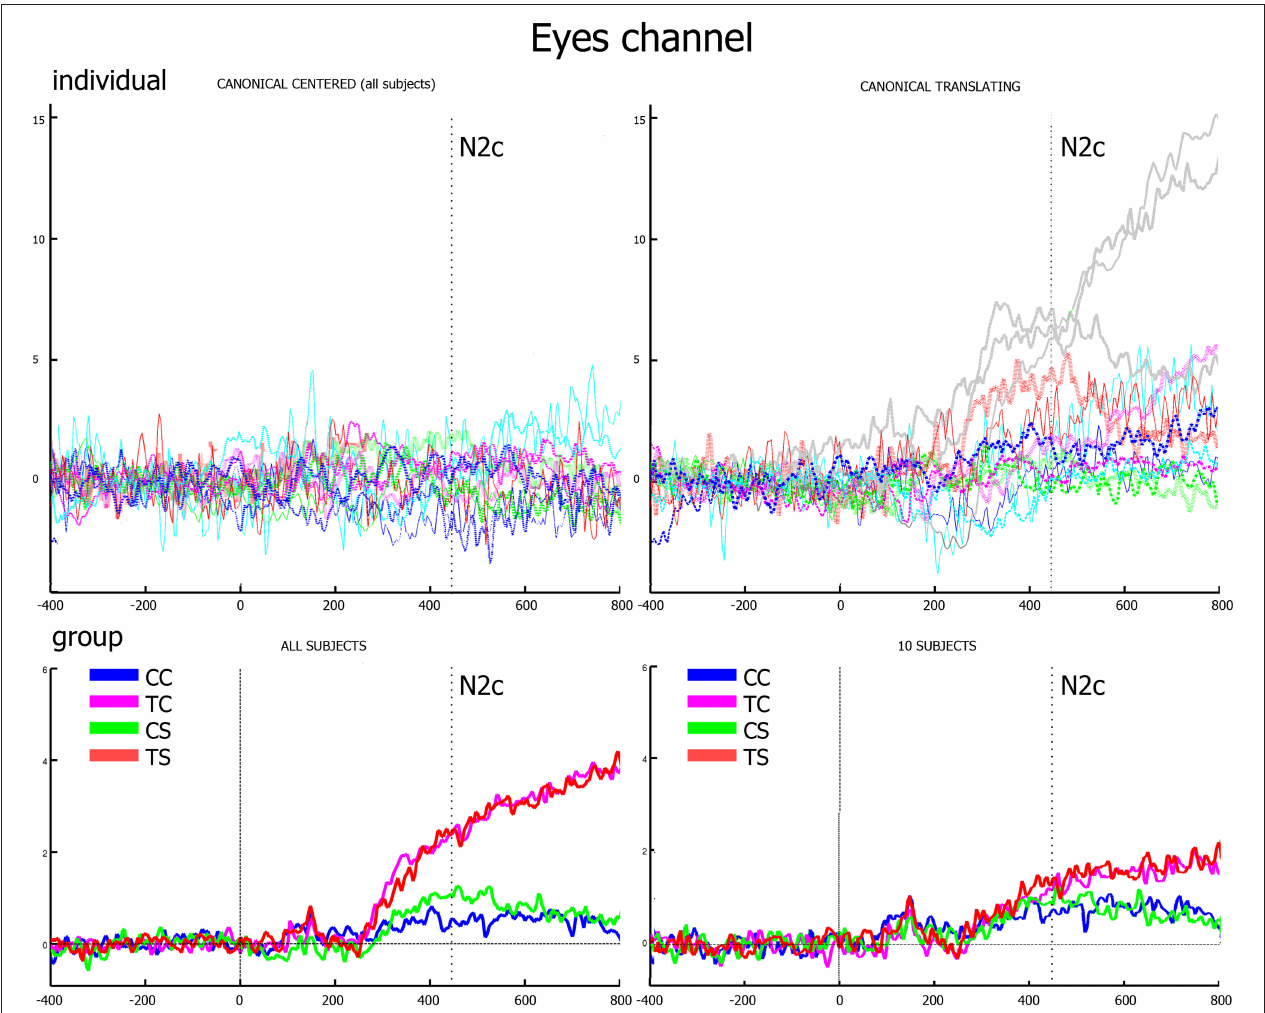
FIGURE 4 | Eye channel traces. In the upper row, the individual traces of canonical center (left) and canonical translating (right) conditions clearly show that only three subjects smoothly pursued the translating stimuli (gray lines). In the lower row, group averages of the whole group (left) and of the not-pursuing subjects group (right) are displayed. The vertical dotted line represents the N2c latency when, in the latter group, eye movements to translating and centered conditions are almost equivalent.